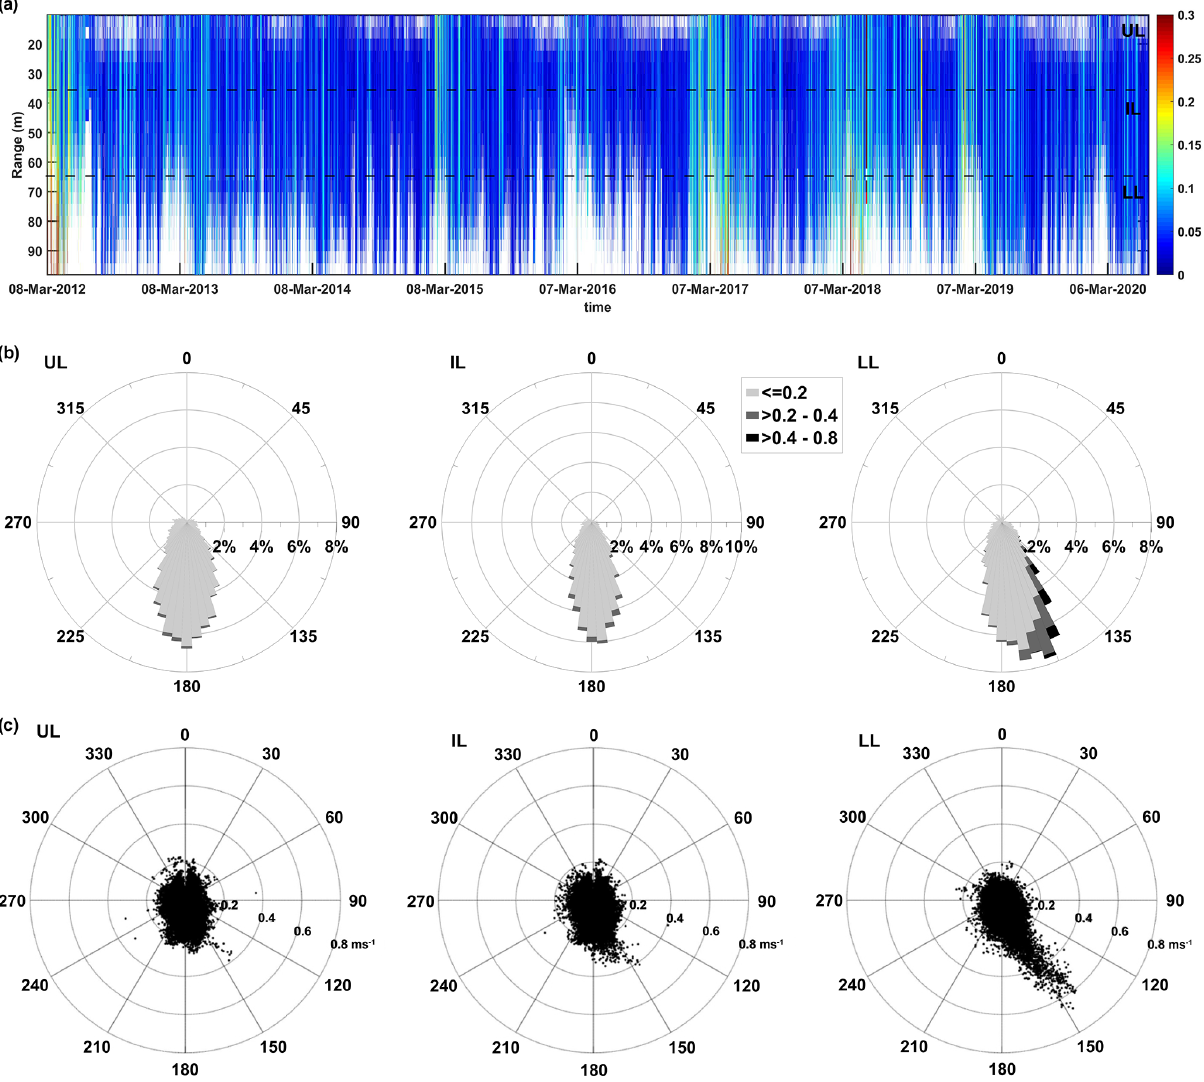
Figure 10. (a) Currents’ speed records along the water column (data filtered by 80% percent good), dotted box indicates the water column corresponding to the three layers used for polar plot representation. (b) Polar probability plot of current velocity in the three layers of the water column (ms − 1 ). (c) Polar scatterplot of observed directional current velocity (ms − 1 ) (UL: upper layer; IL: intermediate layer; LL: lower layer) –